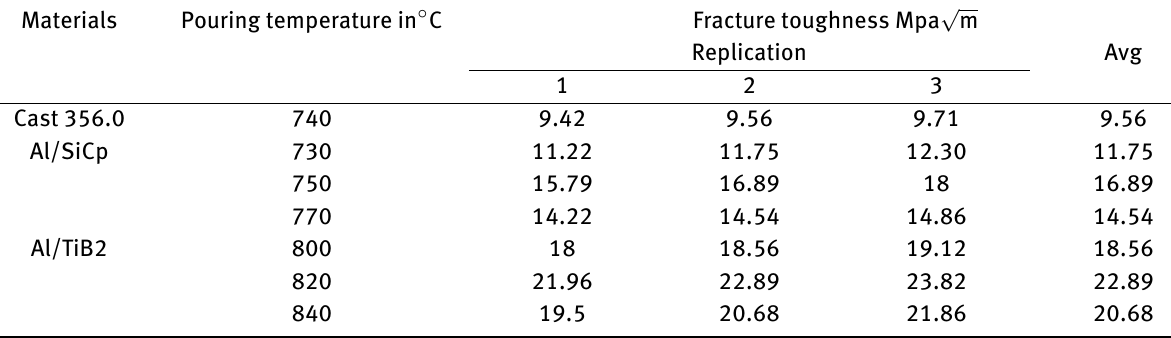
Table 3: Fracture toughness of Al/SiCp and Al/TiB 2 MMCs Materials